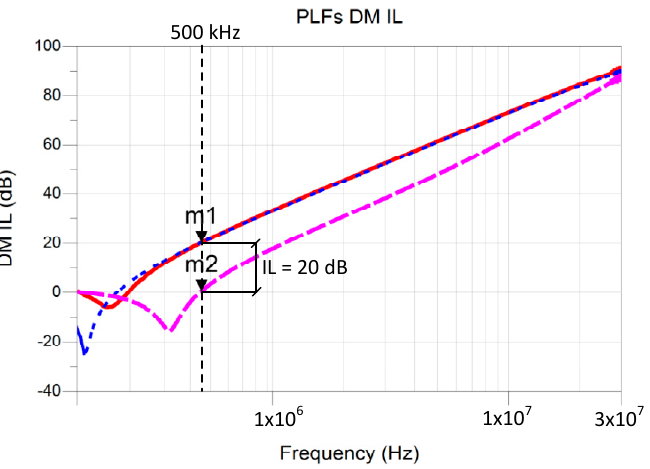
Figure 19. DM IL of PLF 1 (solid red line), PLF 2 (dotted blue line), and PLF 3 (dashed pink line).